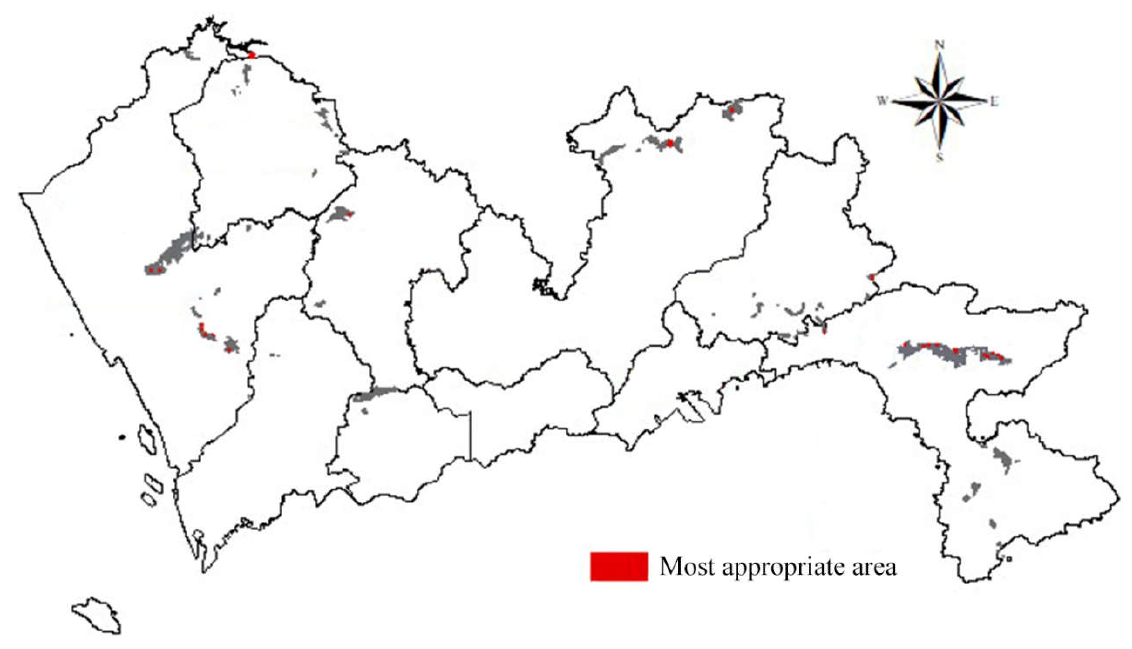
Figure 17. Suitability map of construction waste landfills.